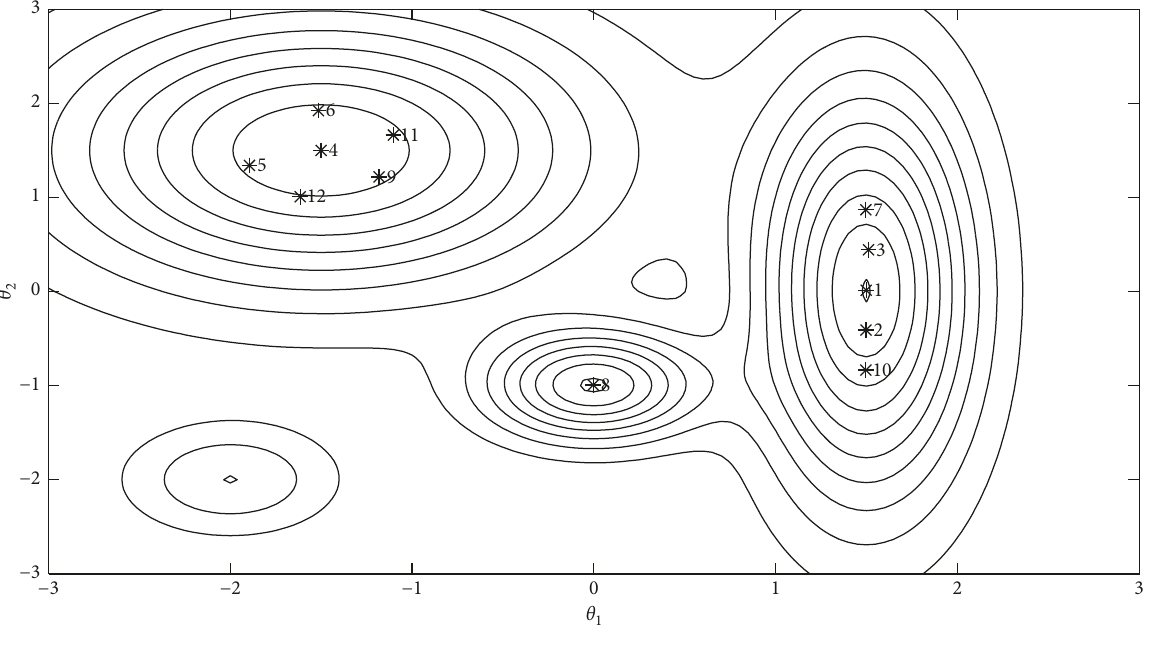
Figure 6: Results using α � 70% and Δ � 5%.